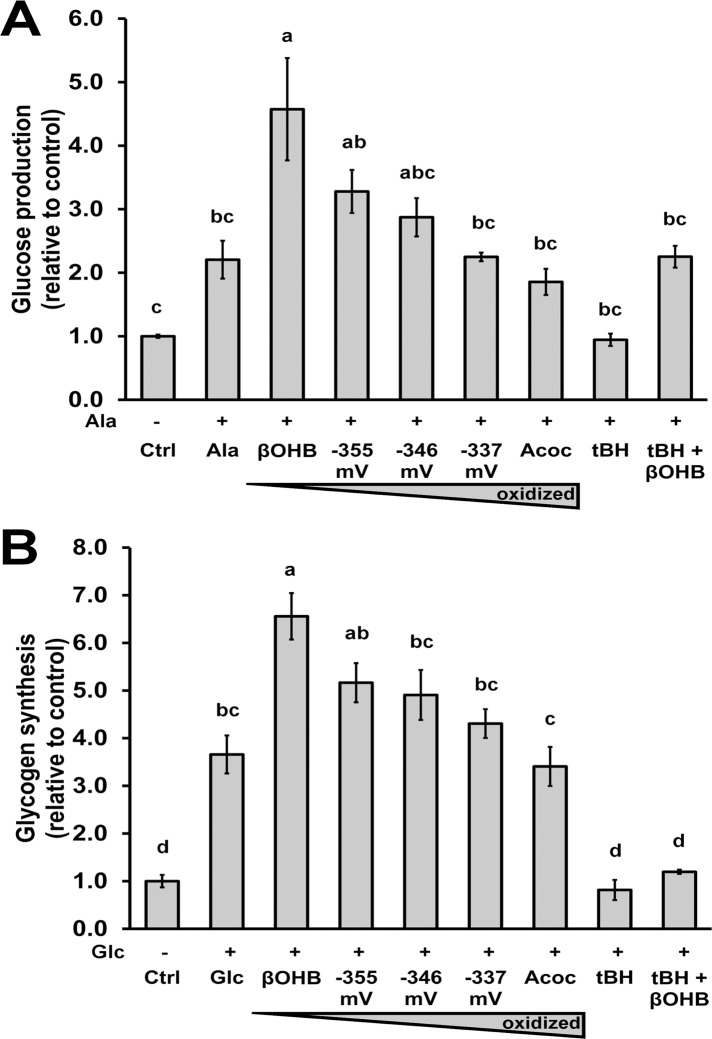
A more reduced redox state stimulates endogenous glucose production and glycogen synthesis.Cells were incubated in Krebs buffer only (control, Ctrl), with 10 mM l-alanine (Ala) as a gluconeogenic substrate for 3.5 hours to assess glucose production (A), or with 30 mM glucose (Glc) as a glycogen substrate to assess glycogenesis (B). All treatments included alanine (A) or glucose (B) except for the control in addition to: 20 mM total active ketone bodies (-355 mV = 2:1 d-βOHB:Acoc; -346 mV = 1:1 d-βOHB:Acoc; -337 mV = 1:2 d-βOHB:Acoc), and/or 40 μM tert-butyl hydroperoxide (tBH). Glucose was measured from the media (A) and glycogen was measured from hepatic stores (B). Data represent Avg ± SE of 3–6 independent experiments. Different letters signify statistical significance (p < 0.05, ANOVA, Tukey’s posthoc analysis).